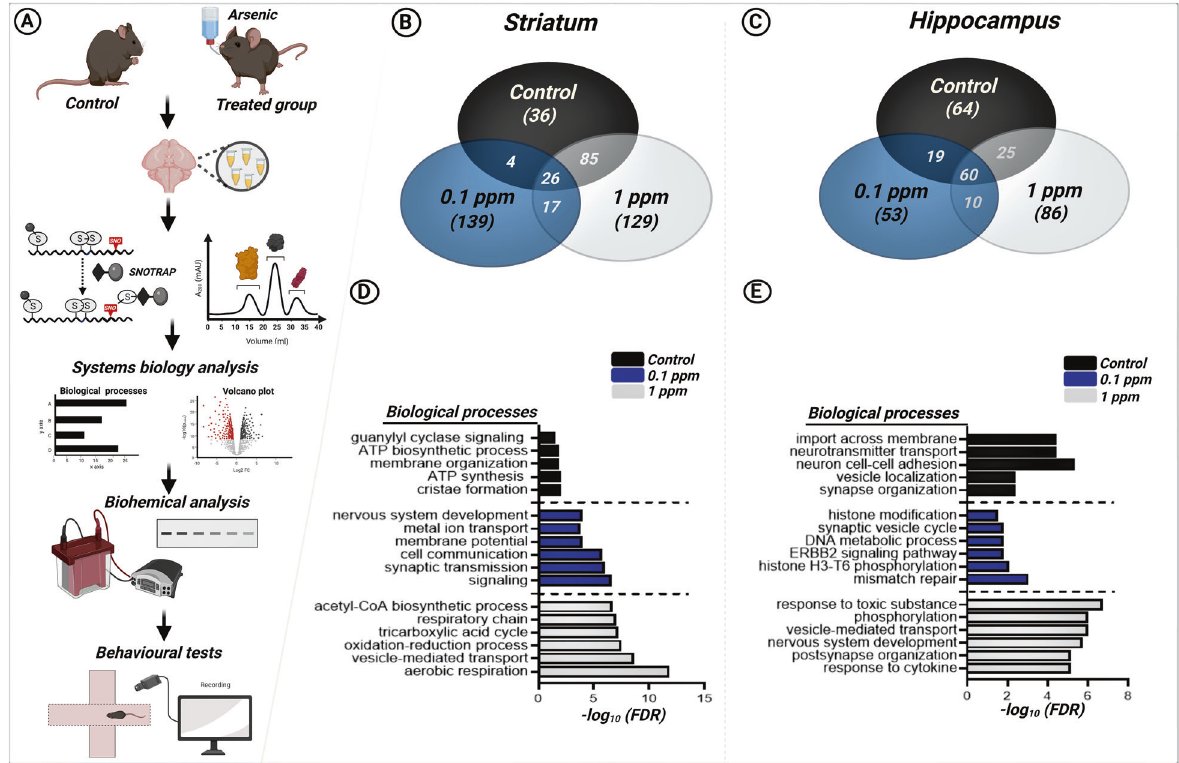
Fig. 1 Systems biology analysis of the SNO-proteome. A Schematic work fl ow for the SNOTRAP-based mass spectrometry analysis of control and SA-treated mice groups followed by large-scale systems analysis, bioinformatics, biochemical, and behavioral studies . B Venn Diagram representing the striatal SNO-proteins identi fi ed in control and SA-treated groups . C Venn Diagram representing the hippocampal SNO- proteins identi fi ed in control and SA-treated groups . D BP analysis, conducted on the striatal SNO proteins that are exclusive to each of the control and both SA-treated groups . E BP analysis, conducted on the hippocampal SNO proteins that are exclusive to each of the control and both SA-treated groups. * Bars represent the – log10 of the Benjamini corrected false discovery rate